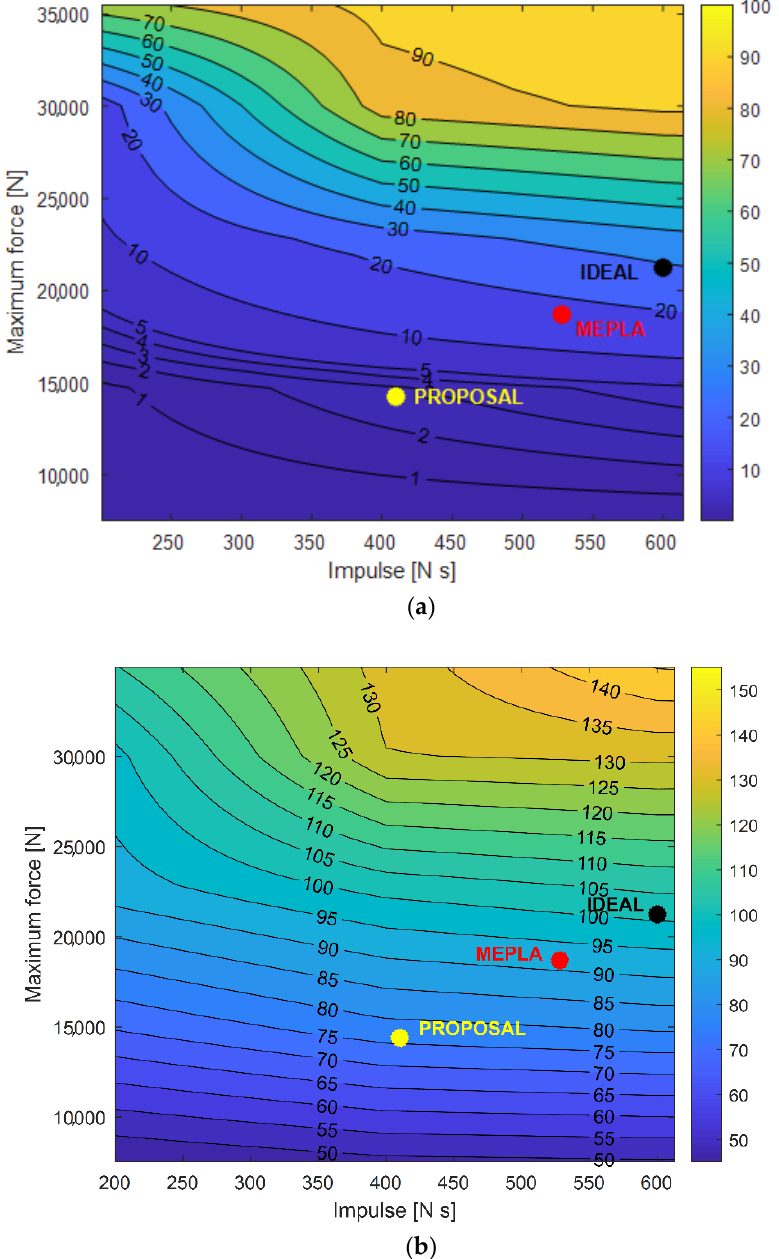
Figure 23. Iso-damage curves based on ( a ) maximum tensile stress or ( b ) probability of failure, based on different calculation methods. In evidence, the proposed approach (SB, E imp = 900 J, P#1).